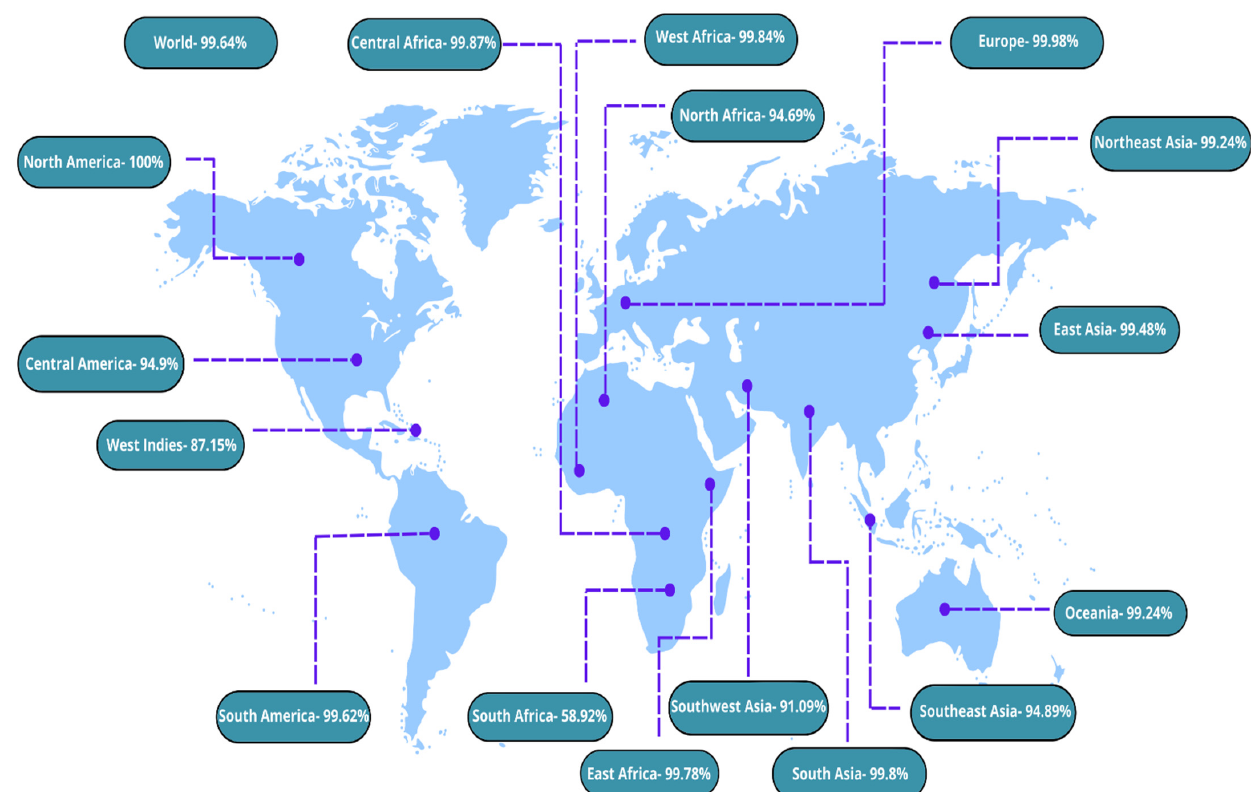
Figure 6. Population coverage analysis.